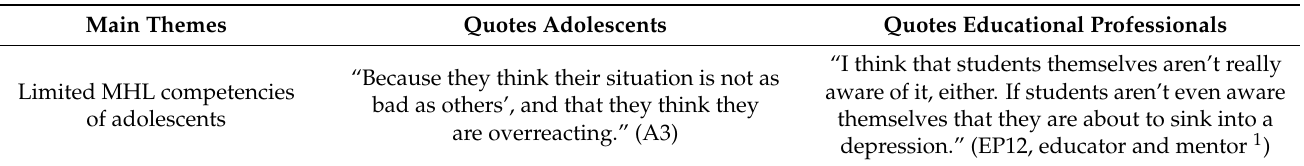
Table 1. Experiences with and perspectives on mental health help seeking in